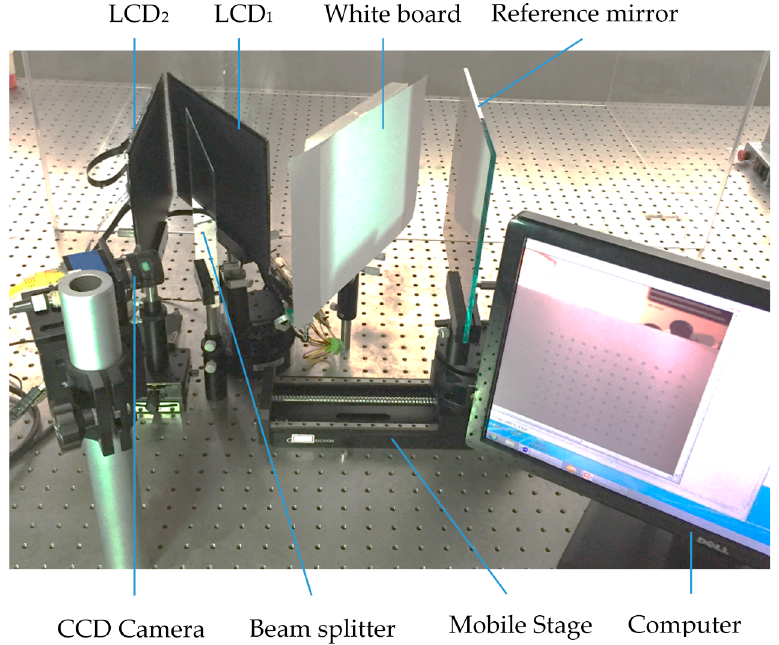
Figure 4. Panorama of DPMD hardware system.